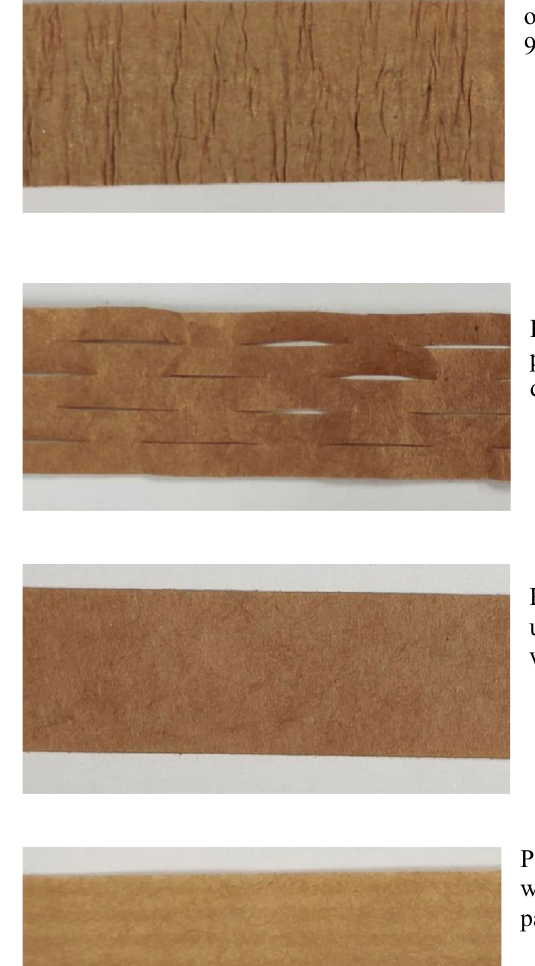
Paper I: unbleached kraft paper without coating, intended for wrapping paper, origin Europe, 58g/m²